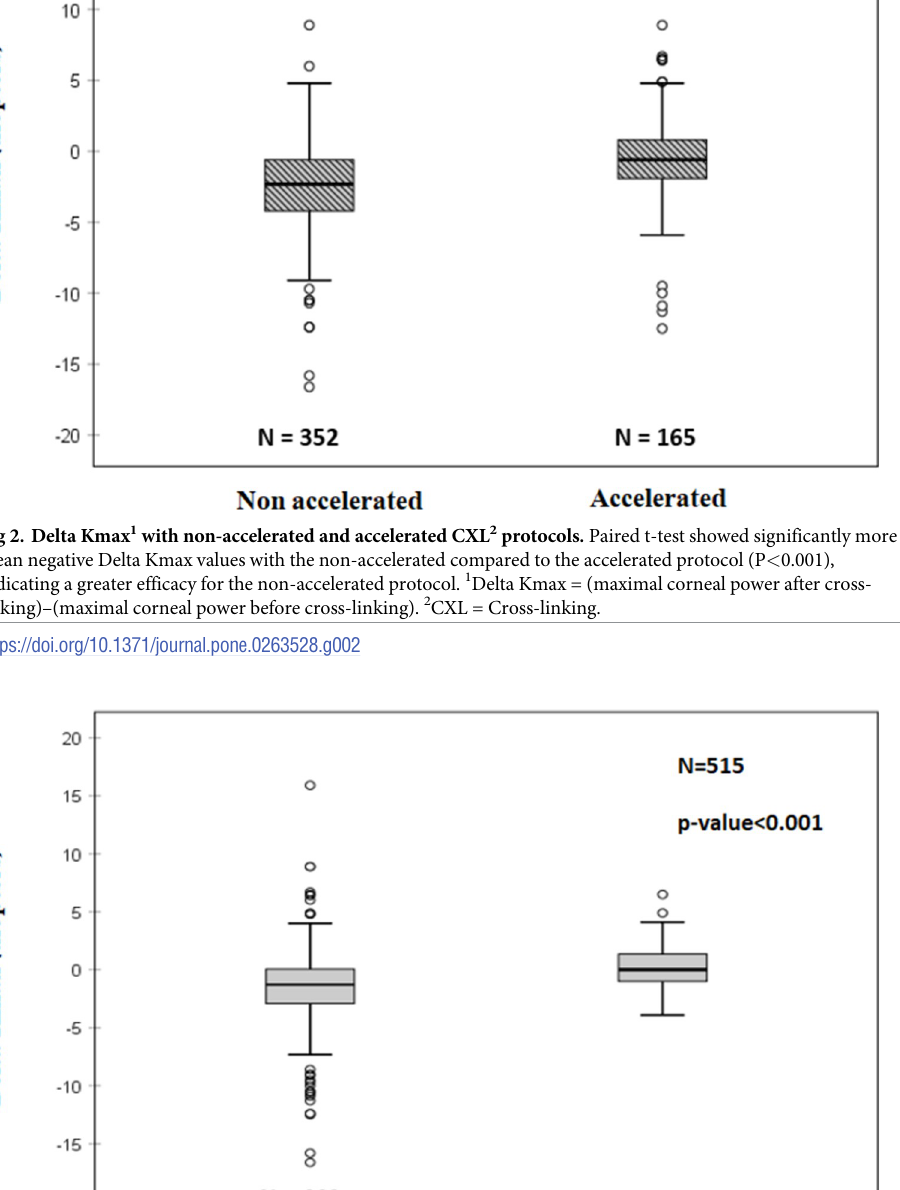
PLOS ONE | https://doi.org/10.1371/journal.pone.0263528 February 3,